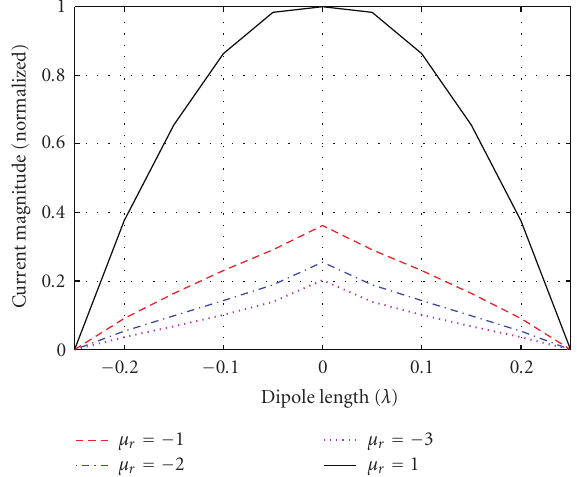
Figure 3: Computed current distribution at 750 MHz. Other pa- rameters: L = 200 mm, r = 0 . 3175 mm, a = 0 . 3175 mm, b = = 1, and N = 10. 1 . 8542 mm, μ r